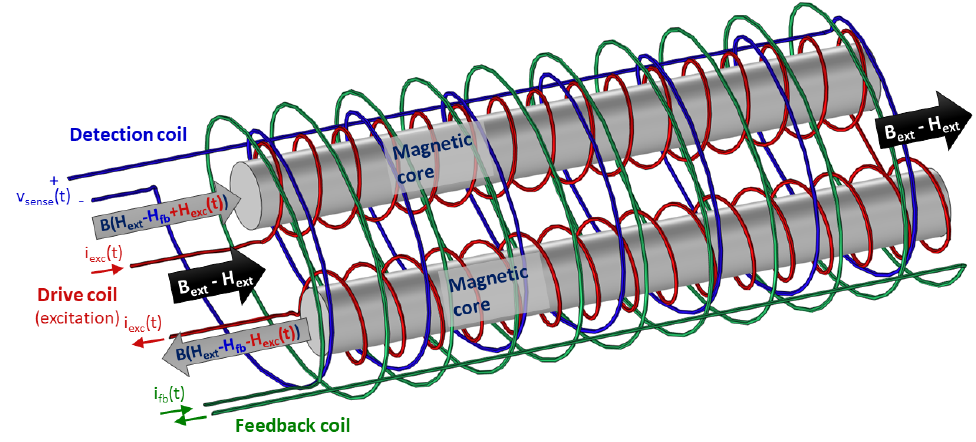
Figure 2. Conceptual scheme of a Vacquier-type fluxgate magnetic sensor (sensing part only). The sensor is constituted of a drive coil (excitation current) wounded in opposite direction around 2 magnetic cores and a detection coil (sense voltage) enveloping both. A feedback (or compensation) coil is added for cancelling the external field and thus increasing the output signal linearity and scale factor